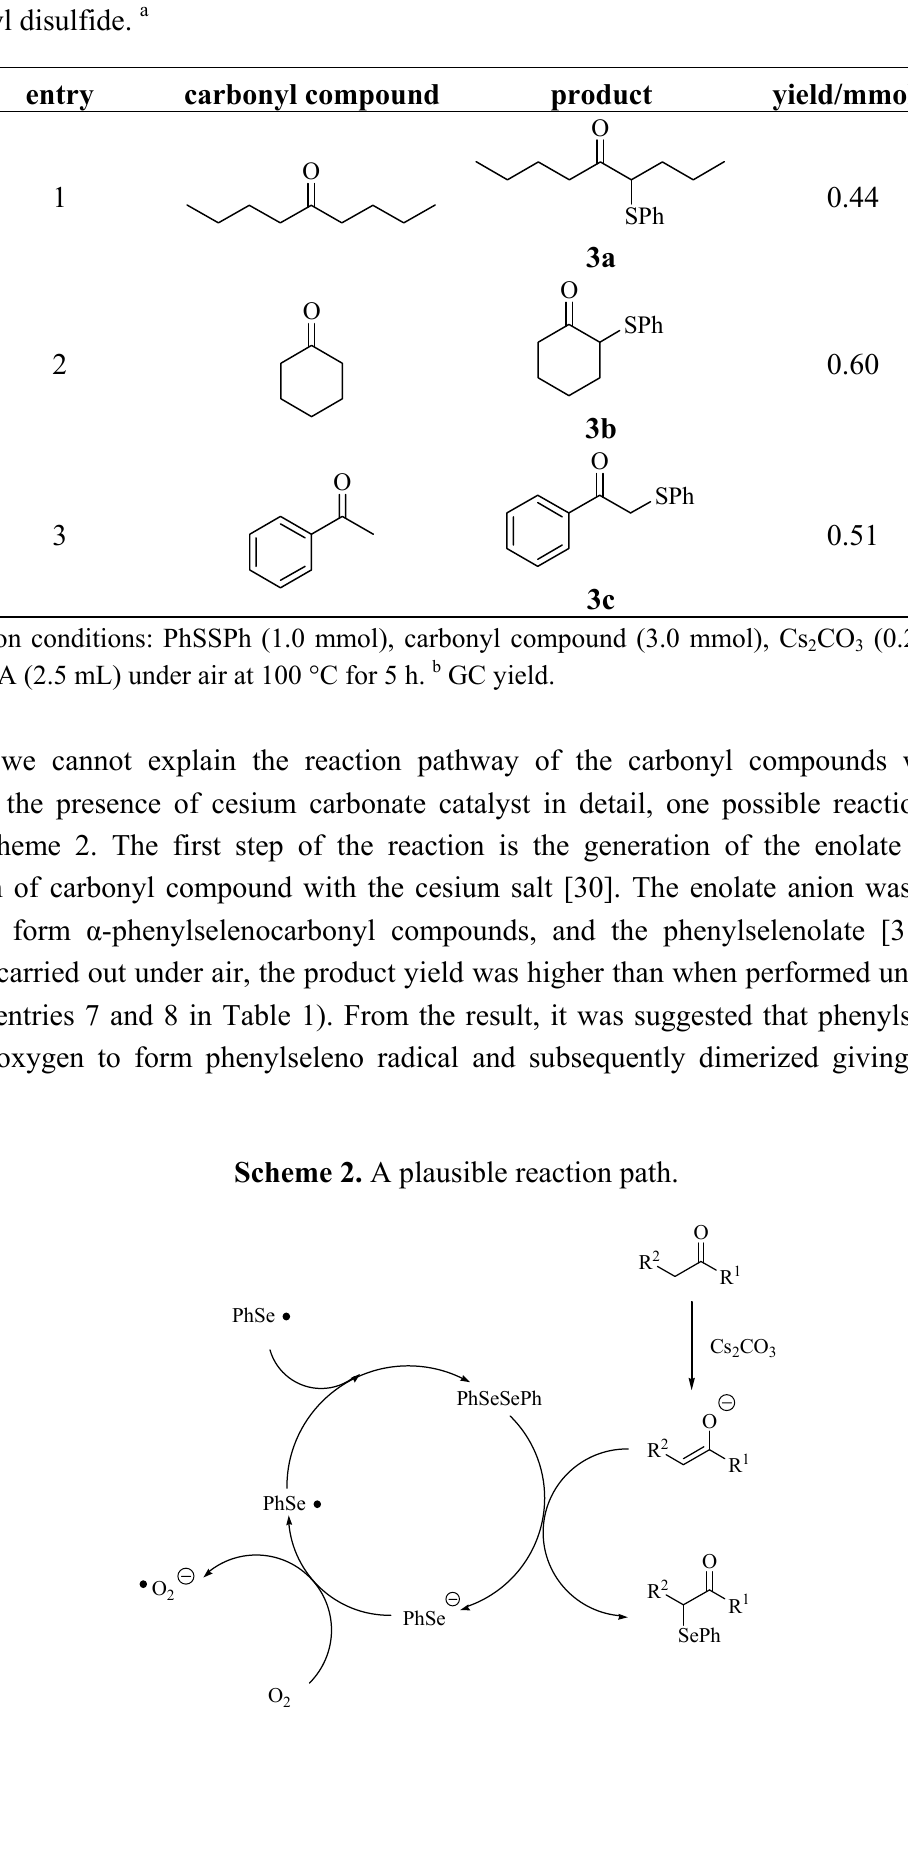
Table 3. Cesium carbonate-catalyzed α -phenylthiolation of carbonyl compounds with diphenyl disulfide.